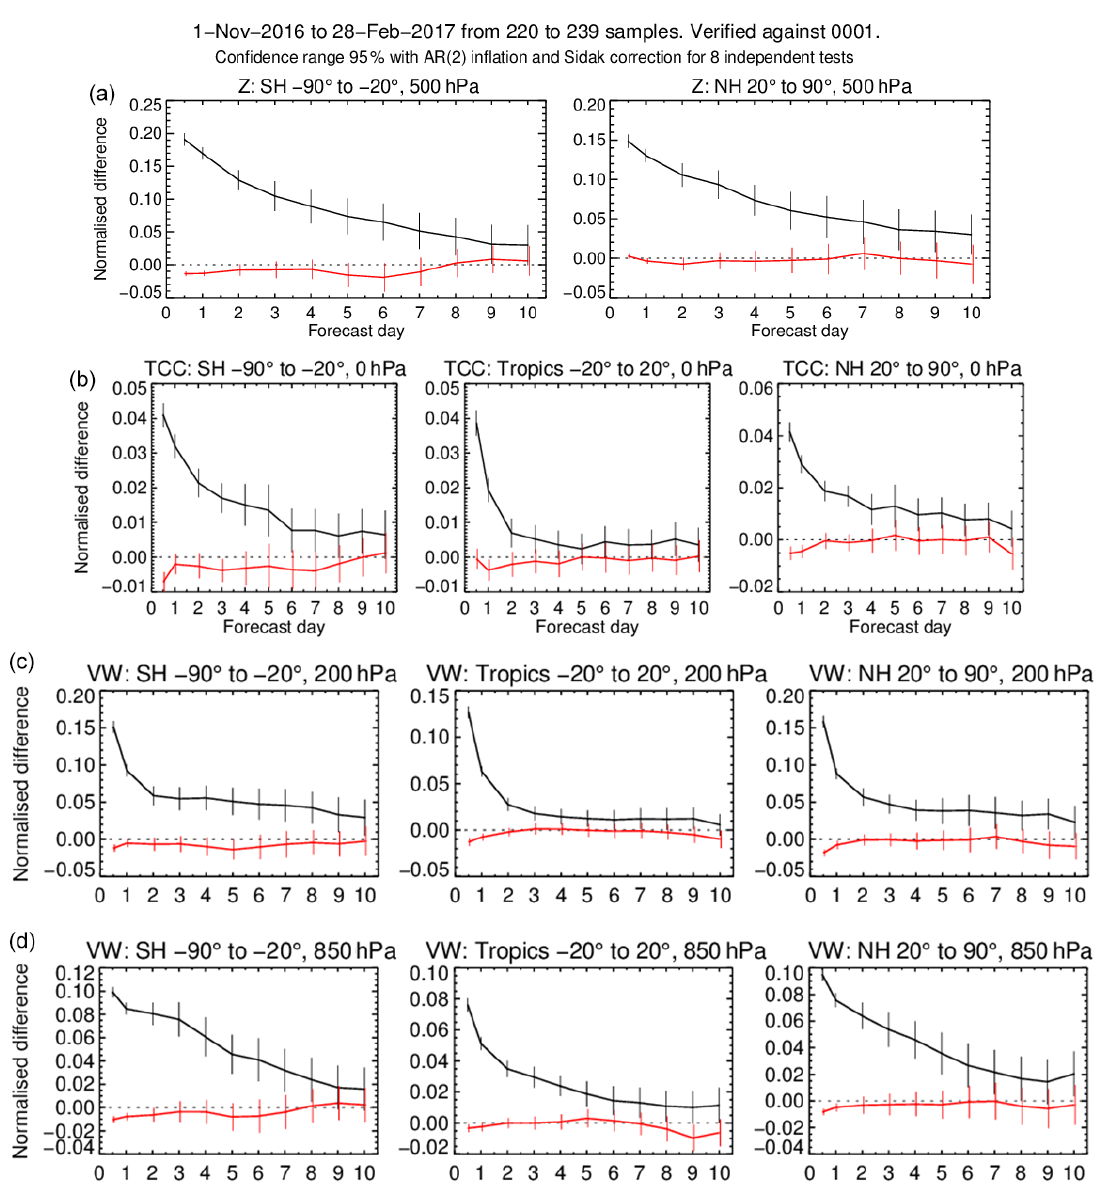
Figure 13. Normalised root mean square forecast errors for geopotential at 500hPa (a) ; total column water vapour (b) ; wind vector at 200hPa (c) ; wind vector at 850hPa (d) for the assimilation experiments using the linear observations subset. The black/red lines refer to the one/four outer loop experiments, respectively. Errors are normalised with respect to the three outer loop experiment and are computed using the operational ECMWF analysis as verification. Error bars represent 95% confidence